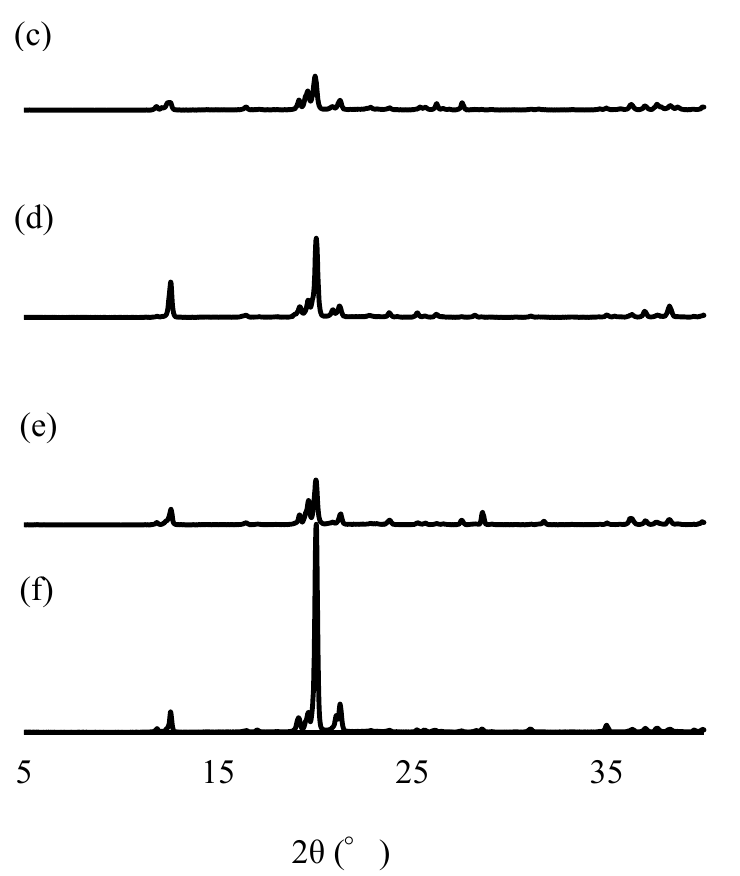
Figure 6. Powder X-ray diffraction patterns of various samples. ( a ) Baclofen crystals, ( b ) lactose, ( c ) baclofen powder just after the preparation, ( d ) baclofen stored in the closed-bottle condition for 60 days, ( e ) 90 days, and ( f ) 120 days.